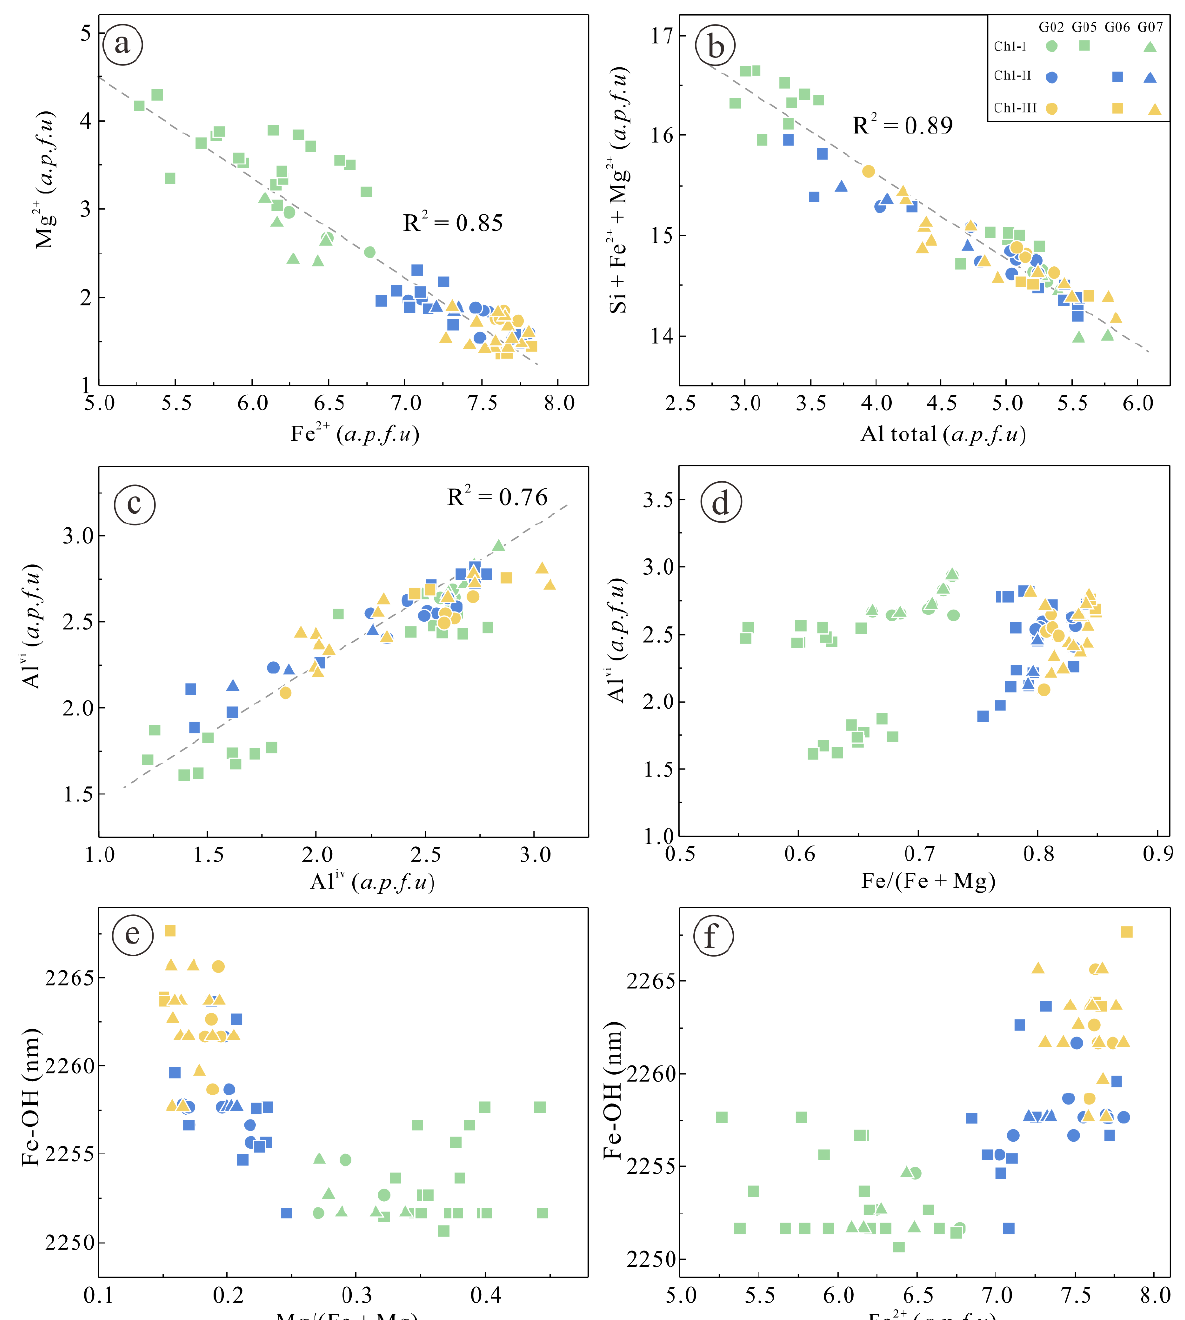
Figure 5. Correlation scatter plots for the chlorite. ( a ) Fe 2+ vs. Mg 2+ ( a.p.f.u ); ( b ) Al (total) vs. Si + Fe 2+ + Mg 2+ ( a.p.f.u ); ( c ) Al iv vs. Al vi ( a.p.f.u ); and ( d ) Fe/(Fe + Mg) vs. Al iv ( a.p.f.u ); ( e ) Fe (total) vs. Pos2250; and ( f ) Fe/(Fe + Mg) vs. Pos2250.